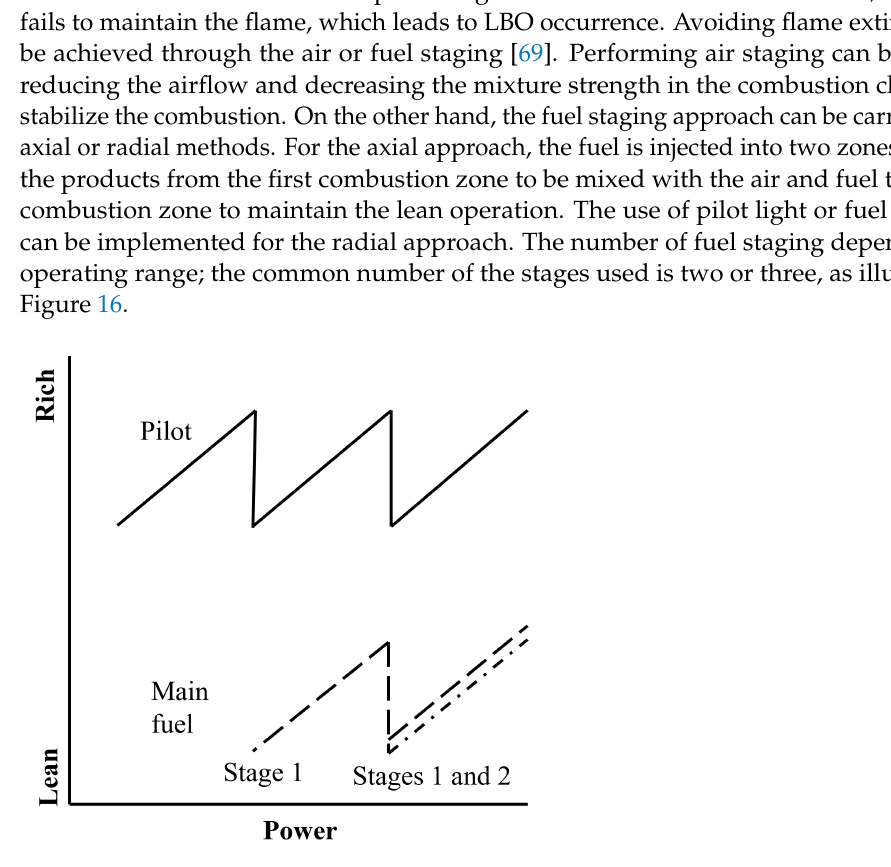
Figure 16. DLE combustor fuel